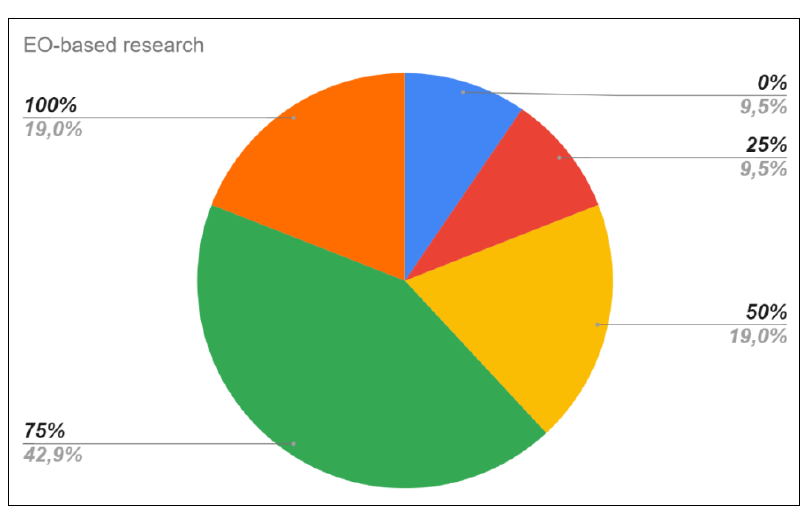
Figure 11. Familiarity of users with EO data.